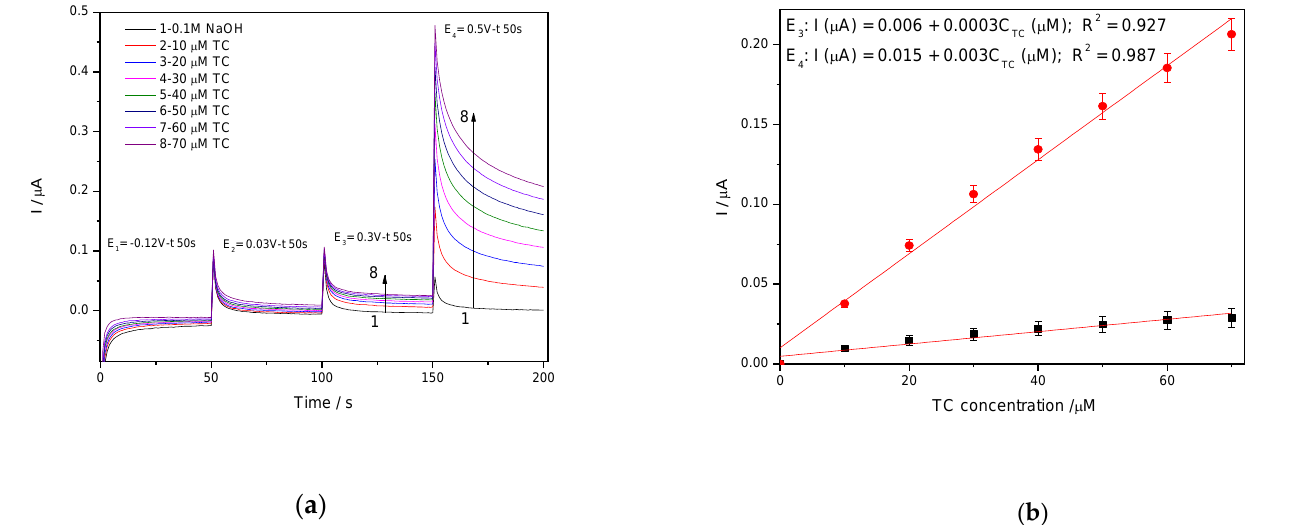
Figure 12. ( a ) Chronoamperometry(CA) recorded on Ag/GO/BDD electrode at the potential value of E 1 = − 0.150 V/SCE, E 2 = +0.030 V/SCE, E 3 = +0.300 V/SCE and E 4 = +0.500 V/SCE in 0.1 M NaOH supporting electrolyte and in the presence of 10 to 70 µ M TC. ( b ) The calibration plots of the currents recorded at E 3 = +0.3 V/SCE and E 4 = +0.500 V/SCE vs. TC